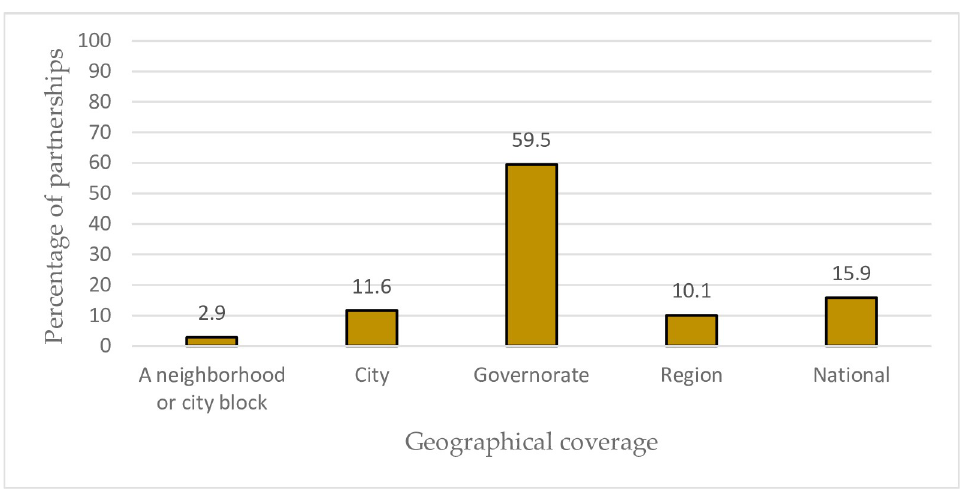
Fig 8. Distribution of the partnerships as per their geographical coverage.